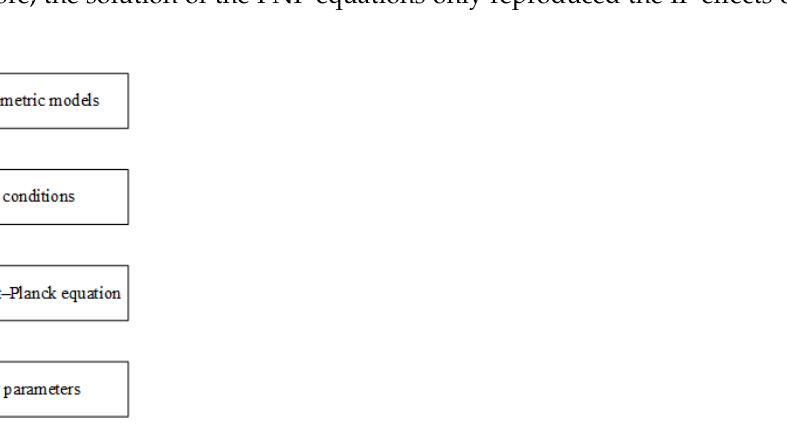
Figure 3. Flow chart of the numerical simulation process based on the Poisson–Nernst–Planck equation. Table 1. Summary of the models corresponding to seafloor disseminated sulfide rocks. ϕ denotes the volume contents of metal sulfides; r denotes the grain radii of sulfide particles. No. Φ (a.u.)